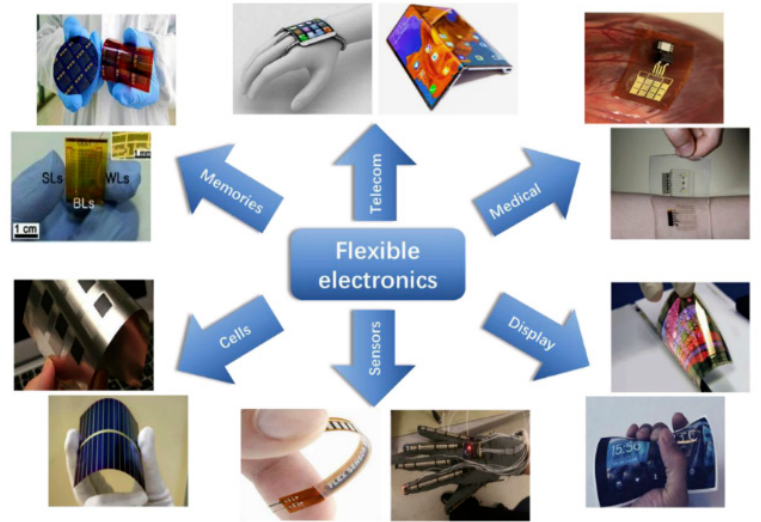
Figure 1. Flexible electronics and some of their applications in daily life [11].